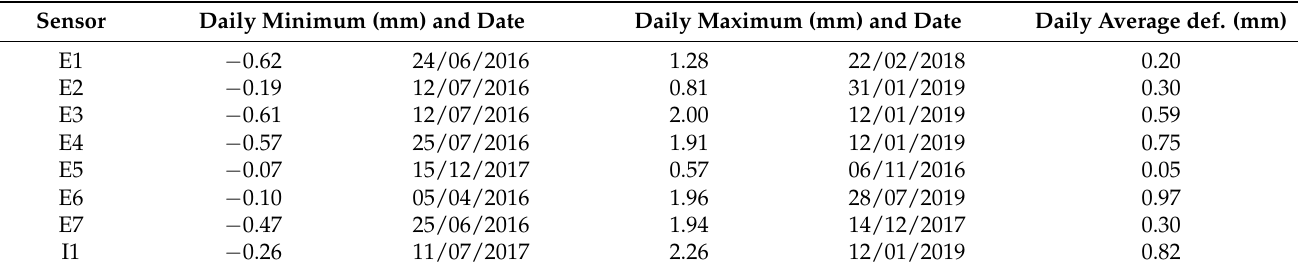
Figure 8. Cumulative deformations measured by extensometers E3 , E4 , and E6 of the monitoring system and their comparison with daily rainfall. Table 2. Minimum, maximum, and average daily deformations measured by the sensors of the monitoring system. Sensor Daily Minimum (mm) and Date Daily Maximum (mm) and Date Daily Average def.